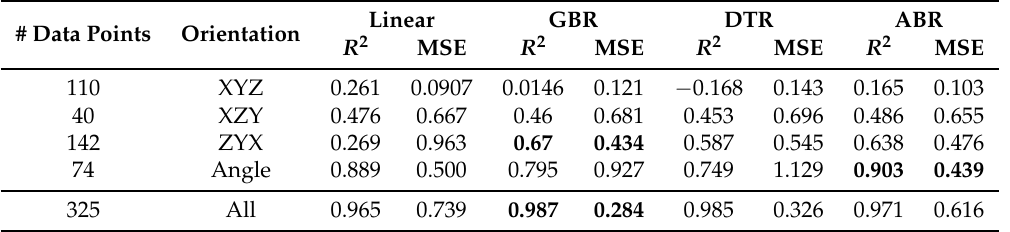
Table 7. Prediction of Elongation at break with a help of machine learning techniques. Linear means linear regression models, GBR stands for Gradient Boost Regressor, DTR—Decision Tree Regressor, and ABR—AdaBoost